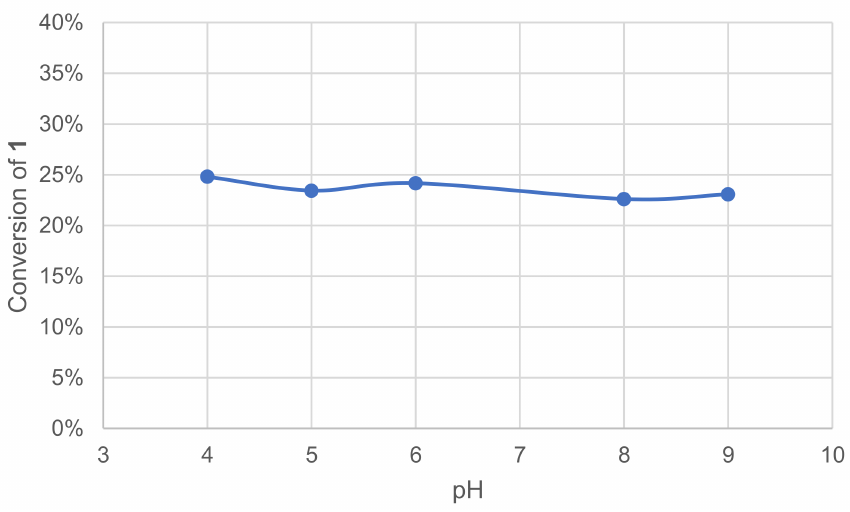
Figure 2. Effect of pH on the conversion of 1 in the laccase-catalyzed oxidation (LA 10% w/w , HOBt